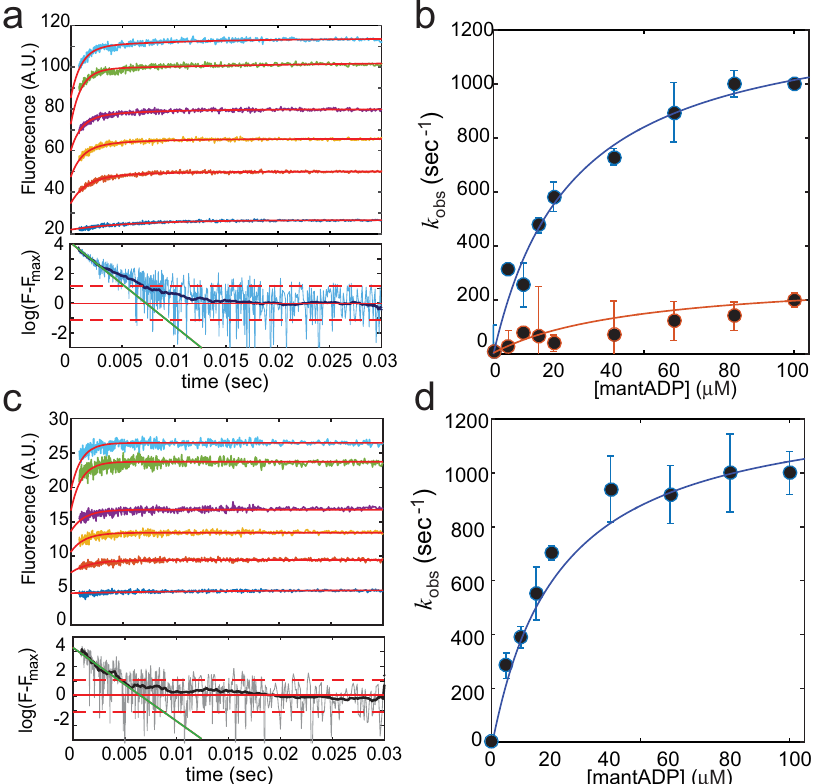
Fig. 3 Transient kinetics of mantADP binding to RecBCD. a Top: Time courses of mantADP binding upon rapid mixing of RecBCD (2 µ M, post-mixing) with mantADP (0 – 100 μ M, lower to upper, respectively). The red lines through the data are the best global fi t to a double exponential function (Methods). Bottom: Log-scale representation of the normalized intensity highlights the deviation from a single exponential. The light-blue line shows raw data of 60 μ M and the dark-blue fi ltered data (Methods). Red horizontal lines indicate the mean (full line) and standard deviation (two dashed lines) of the noise. The green line is the best linear fi t for the fi rst 4 msec. In the time window from time t = 0 to the time when the signal equals the noise, up to a standard deviation, the data shows deviation from a single exponential decay. b Dependence of k fast (Blue) and k slow (Orange) on [mantADP], as obtained from obs obs fi tting n = 7 independent measurements for each concentration. The error bars represent the standard error obtained from the fi t. The solid line through the data points are the best hyperbolic fi ts. c Top: Time courses of mantADP binding upon rapid mixing of RecBCD (2 µ M, post-mixing) with mantADP (0 – 100 μ M, lower to upper, respectively) in the presence of 2 mM adenosine. The red lines through the data were the best global fi t to a single exponential function (Methods). Bottom: Log-scale representation of the normalized intensity highlights a consistency with a single exponential. The gray line shows raw data of 60 μ M and the black fi ltered data (Methods). Red horizontal lines indicate the mean (full line) and standard deviation (two dashed lines) of the noise. The green line is the best linear fi t for the fi rst 4 msec. d Dependence of k obs on [mantADP] in the presence of adenosine, as obtained from fi tting n = 7 independent measurements for each concentration. The error bars represent the standard error obtained from the fi t. The solid line through the data points are the best hyperbolic fi